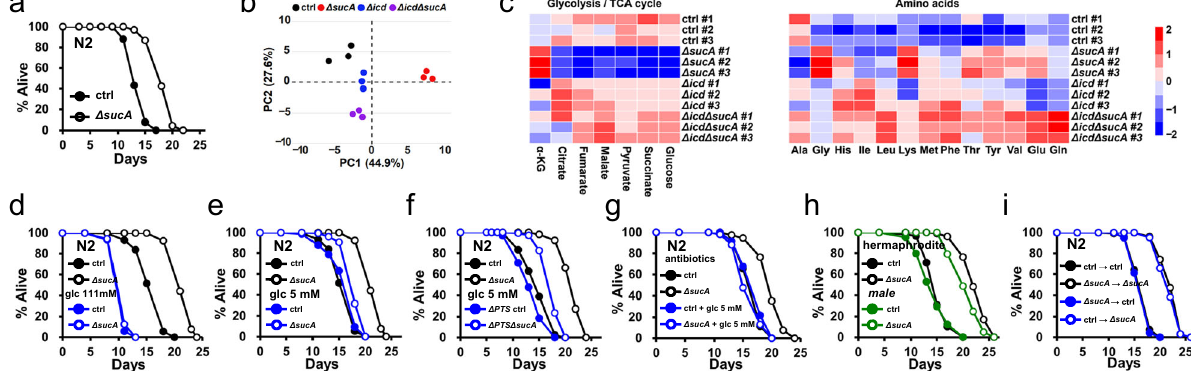
Fig. 1 | Glucose-depleted E. coli mutants promote longevity of C. elegans . a Lifespan showing that Δ sucA Escherichia coli mutants extend lifespan of Cae- norhabditis elegans ( P <1.0×10 − 10 , P value determined by two-tailed Student ’ s t test). E. coli K12 parental strain (BW25113) is indicated as ctrl. Results from one of three independent experiments are shown. b PCA analysis of metabolites from control, Δ icd , Δ icd Δ sucA and Δ sucAE.coli .Metabolitesfromthreebiologicalrepeats are analyzed using 1 H-NMR. PC1 and PC2 indicate principal component 1 and principal component 2. Each point represents an independent biological sample. c Heat map analysis of metabolite quanti fi cation data. The row represents the sample and the column represents metabolite.Metabolites signi fi cantly decreased are displayed in blue, whereas metabolites signi fi cantly increased are displayed in red. The brightness of each color corresponds to the magnitude of the difference when compared with average values. The glycolysis-TCA metabolites and amino acids are presented. For total metabolites data, see also Supplementary Table 2. d Lifespan showing that 2% glucose (111mM) treatment completely suppress the lifespan extension by GR diets ( P =0.3318, P value determined by